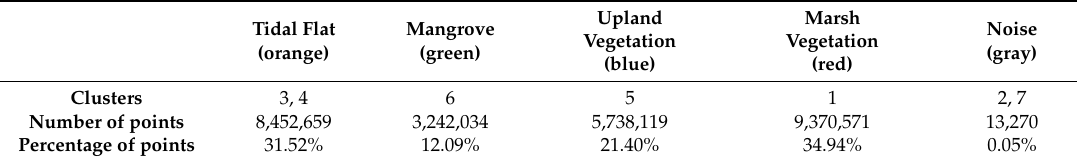
Table 2. Cluster decomposition of the scene for TLS.